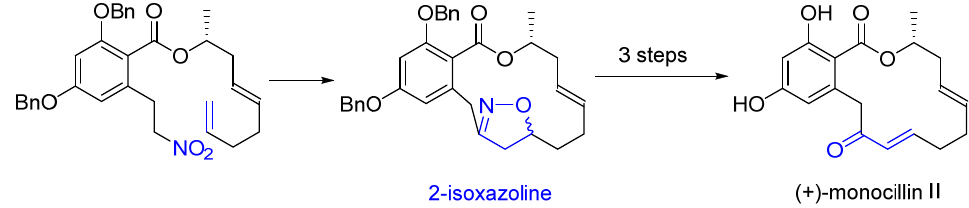
Figure 2. Application of 2-isoxazoline as a key building block.